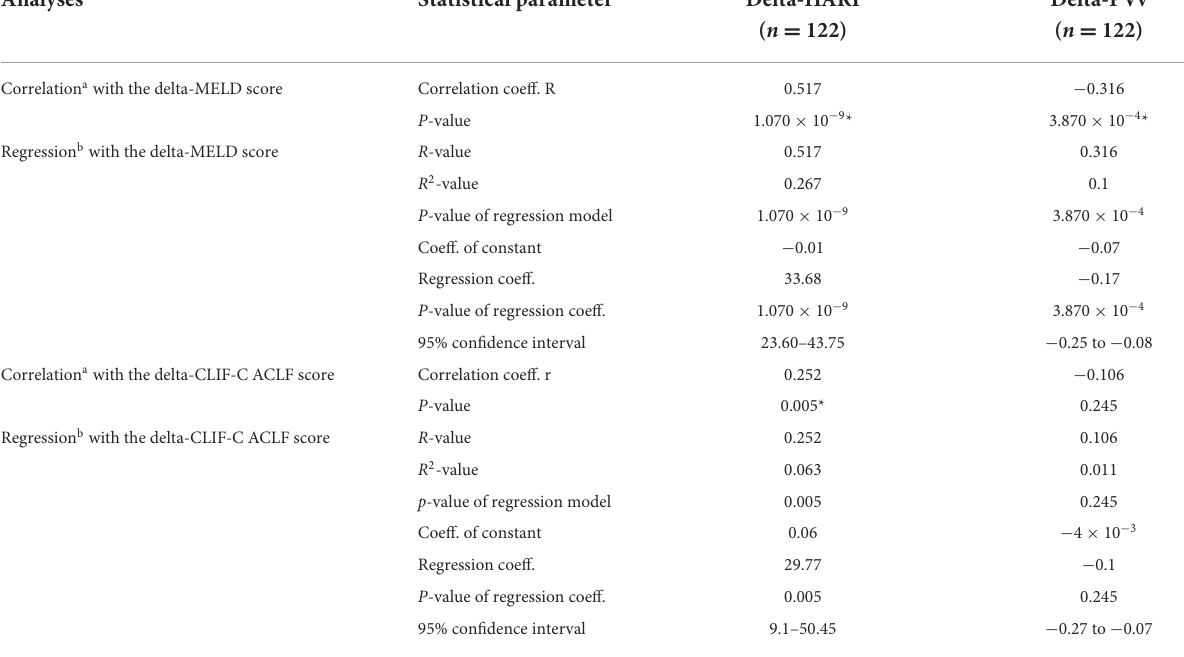
TABLE 5 Subgroup analyses—Correlation and regression analyses between perfusion parameters and delta-MELD score and delta-CLIF-C ACLF score for patients with liver cirrhosis.